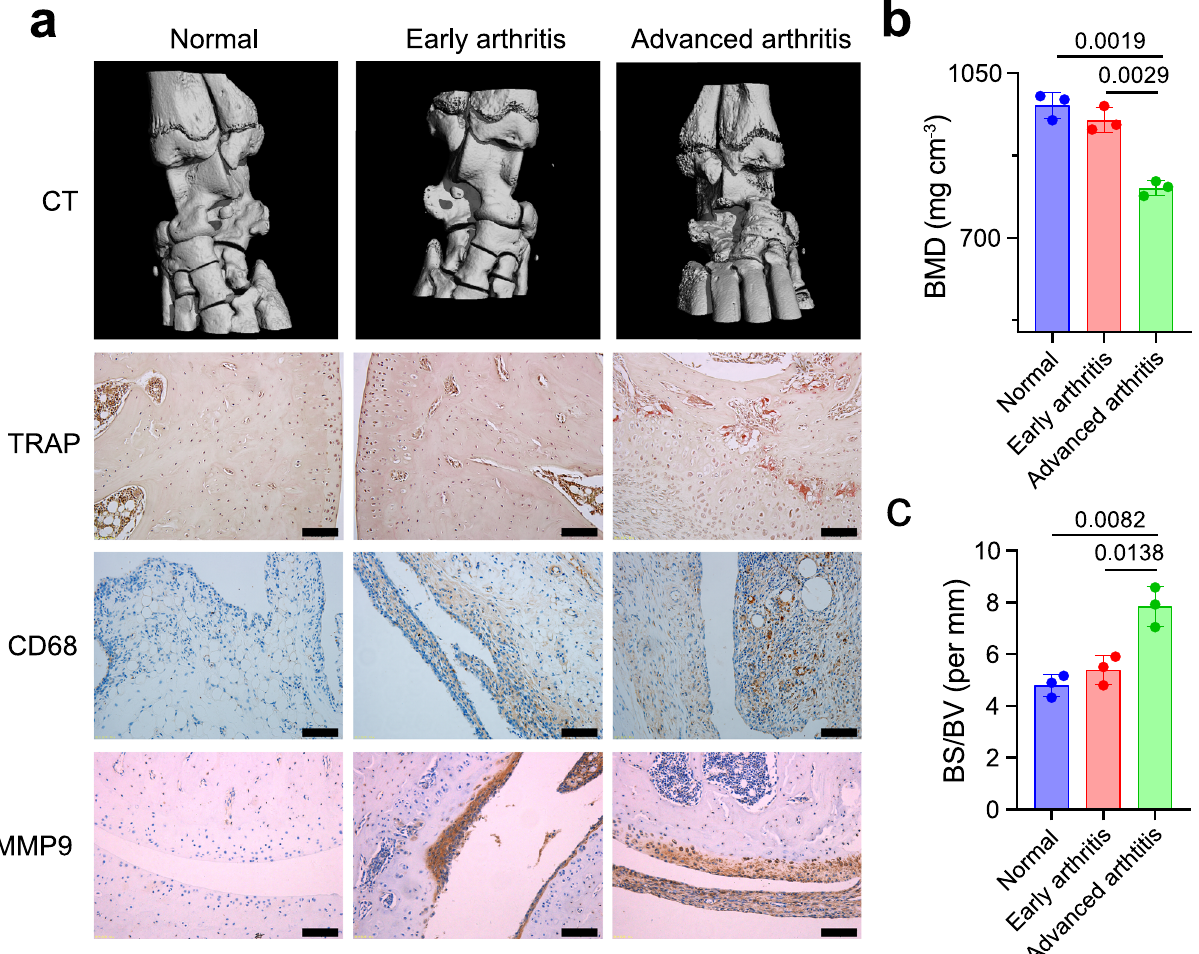
Fig. 1 Pathological features differ between rats with early and advanced arthritis. a OCs-induced bone erosion and macrophages-mediated synovial in fl ammation in advanced arthritis. Representative micro-CT images of ankle joints showing bone erosion levels in ankle joints from normal rats, AIA rats with early-stage arthritis, and AIA rats with late-stage arthritis. Immunohistochemical analyses of the TRAP (tartrate-resistant acid phosphatase)-stained OCs, CD68 + synovial macrophages, and MMP9 (matrix metalloproteinase 9) expression in the joint tissues from rats in each group ( n = 3). Scale bar = 100 μ m. b , c Quantitative micro-CT analyses of bone mineral density (BMD) and bone surface density (BS/BV). Data represent the mean ± SD ( n = 3 independent animals). Statistical signi fi cance was determined by a two-sided Student ’ s t